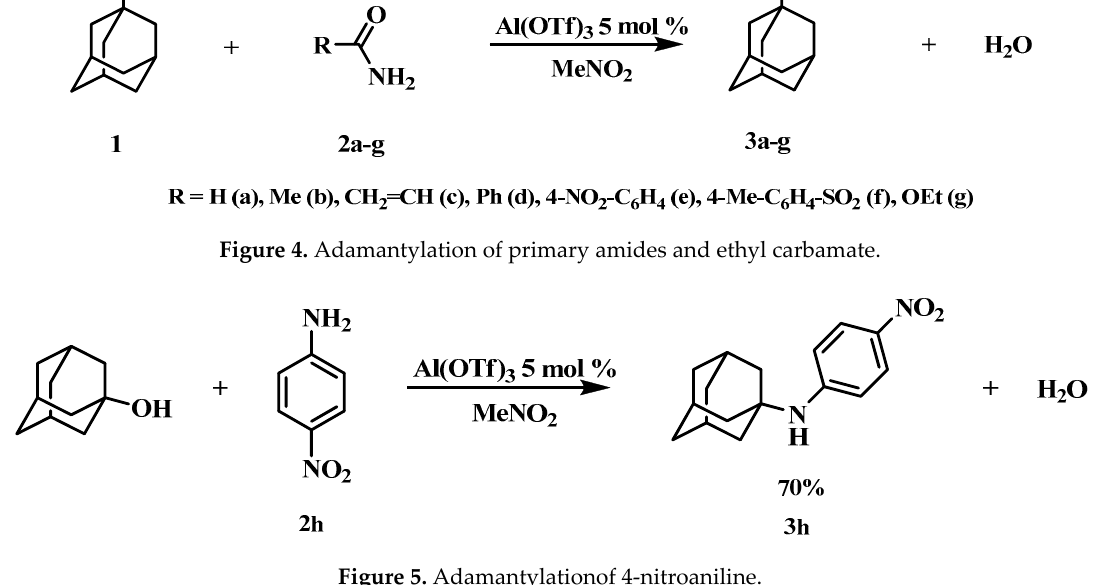
Figure 5. Adamantylationof 4-nitroaniline.